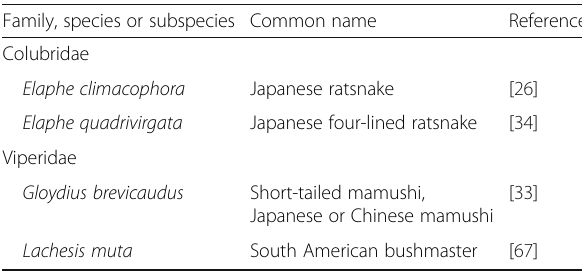
Table 2 Snake blood PLA 2 inhibitors in the structural beta class (sb β PLIs)